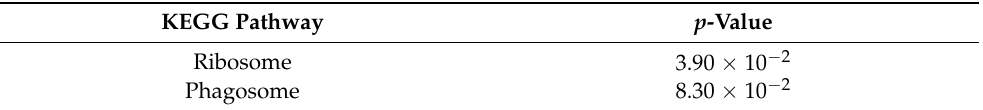
Table 2. KEGG pathway analysis of the O. vulgaris skin mucus proteome by DAVID (https://david. ncifcrf.gov/home.jsp, accessed on 6 June 2022).